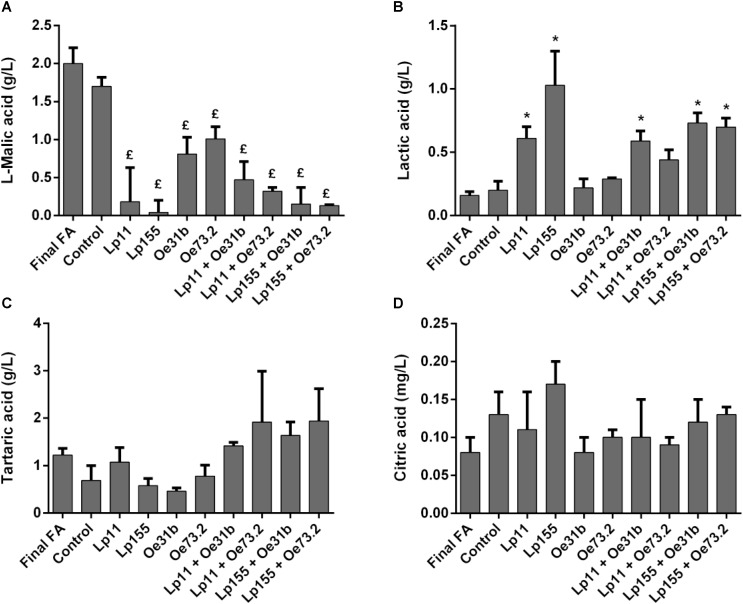
Remaining concentration of L-malic (A), tartaric (C), and citric (D) acids, and production of L-lactic acid (B), measured after 14 days of wine samples incubation. Final FA refers to wine at day 0 of the assay. Control sample refers to non-inoculated wine at day 14. Data are presented as mean ± SD and compared by one-way ANOVA followed by a Dunnett post-test for multiple comparisons. (£) indicates significantly lower respect to control before MLF (p < 0.05); (∗) indicates significantly higher respect to control before MLF (p < 0.05). No significant differences in the tartaric and citric acid concentrations were observed (p > 0.05).